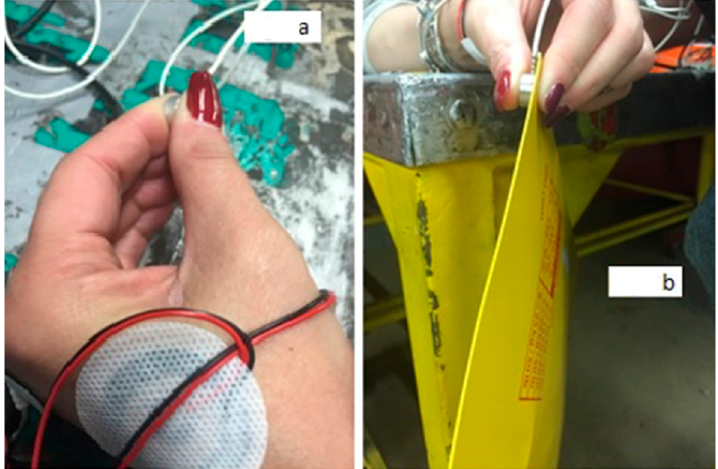
Figure 1. ( a ) Setup used for sEMG and force exerted during MVIC and spontaneous force (SF) in isometric conditions; the force during pinch grip is recorded by using a load cell and a dedicated acquisition system (P-forceMet, OT Bioelettronica, Italy). ( b ) Setup for the acquisition of the sEMG and SF during the lifting of 100 g and 500 g envelopes.